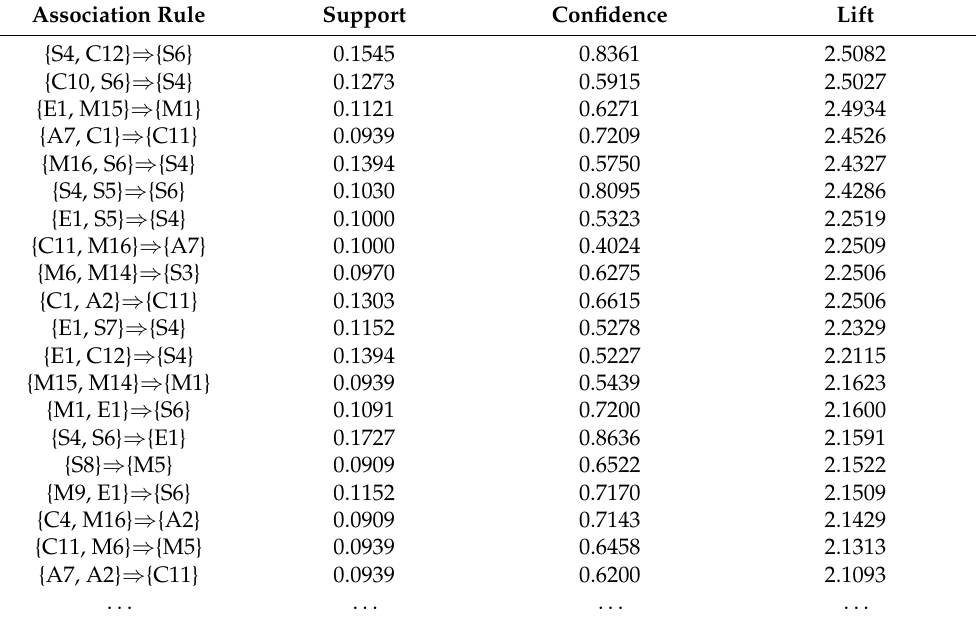
Table 6. Some of the association rule